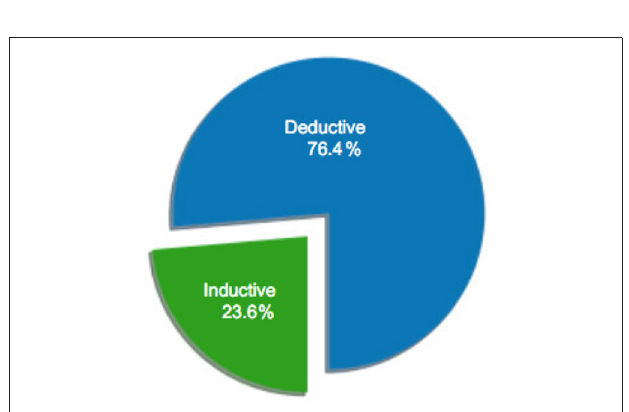
FIGURE 5 | Percentage of sample articles by research